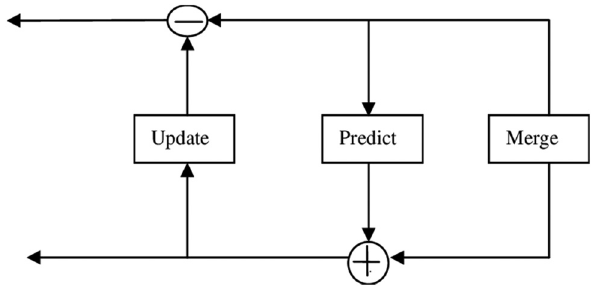
Figure 3: Reverse lifting